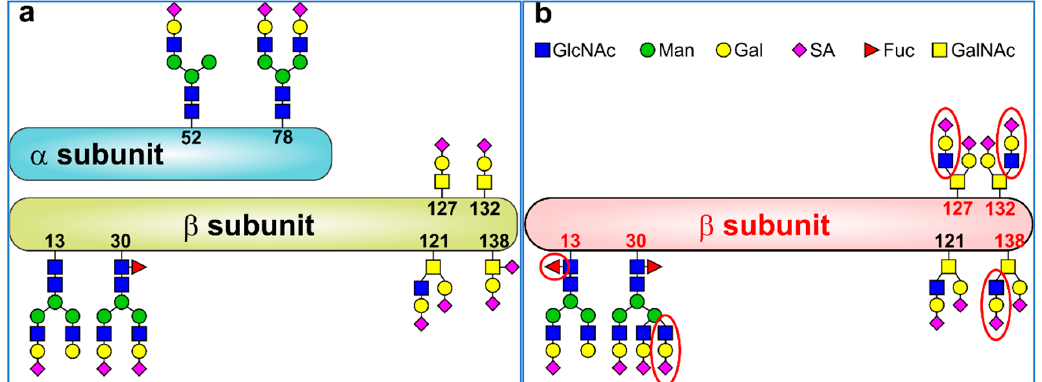
Figure 2. ( a ) A typical structure of hCG with 2 N -glycans in the α subunit of the hCG (hCG α ) at Asn52 and Asn78, while the β subunit of hCG (hCG β ) contains 2 N -glycans (Asn13 and Asn30) and 4 O -glycans (Ser121, Ser127, Ser132 and Ser138). The glycan composition shown here for hCG β is a typical structure present in the protein from a pregnant woman; ( b ) The structure of β subunit of hyperglycosylated hCG (hCG-H) i.e., hCG β -H present in various malignancies including TC. While type 2 O -glycan is present in both forms of hCG β and hCG β -H at Ser121, hCG β -H contains type 2 O -glycans at all O -glycan sites (Ser127, Ser132 and Ser138). The differences in the glycan composition between hCG β and hCG β -H are highlighted by a red ellipse. Abbreviations used: GlcNAc = N -acetylglucosamine, Man = mannose, Gal = galactose, SA = sialic acid, Fuc = fucose and GalNAc = N -acetygalactosamine. Redrawn from [35], Copyright (2016), with permission from Elsevier.